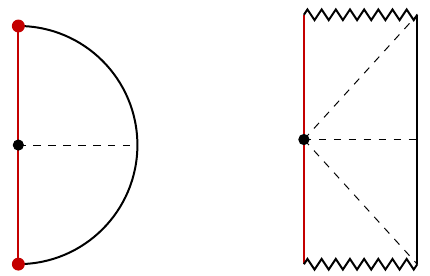
Figure 14 . The euclidean and lorentzian space-time dual to the extremal partially entangled state (1.7) with (cid:12) ! 1 and ‘ = k L R